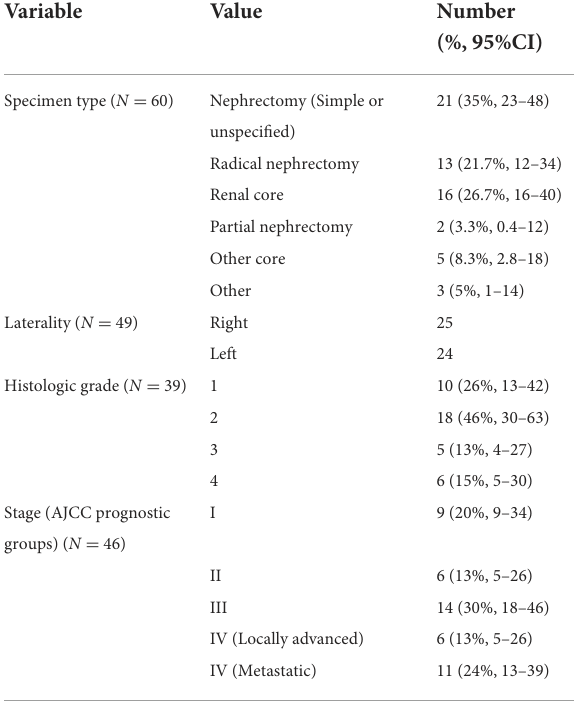
TABLE 3 Data on specimen type, tumor laterality, histologic grade, and tumor